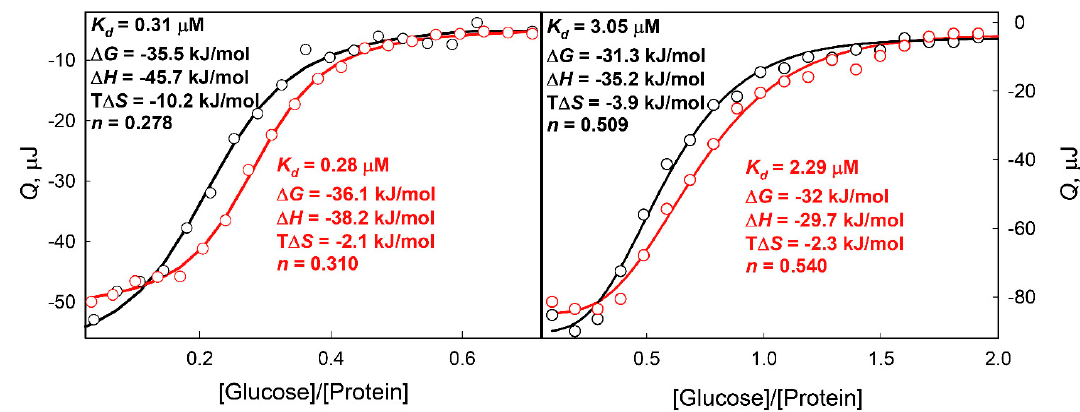
Figure 7. Isothermal calorimetric titration (ITC) analysis of the wtGGBP and GGBP/H152C interaction with glucose. ITC profiles for wtGGBP (left panel) and GGBP/H152C (right panel) in solution without denaturants (black circles) and in the presence of 0.1 M GdnHCl (red circles) are shown. The curves represent best fit of experimental data by the independent binding sites model. The glucose initial concentrations were 0.25 mM (for wtGGBP) and 0.7 mM (for GGBP/H152C). The initial protein concentrations were 0.035 mM.